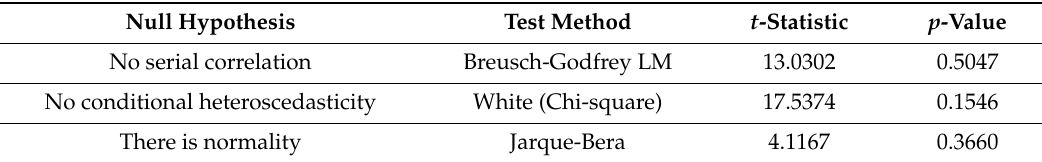
Table 8. Diagnostic